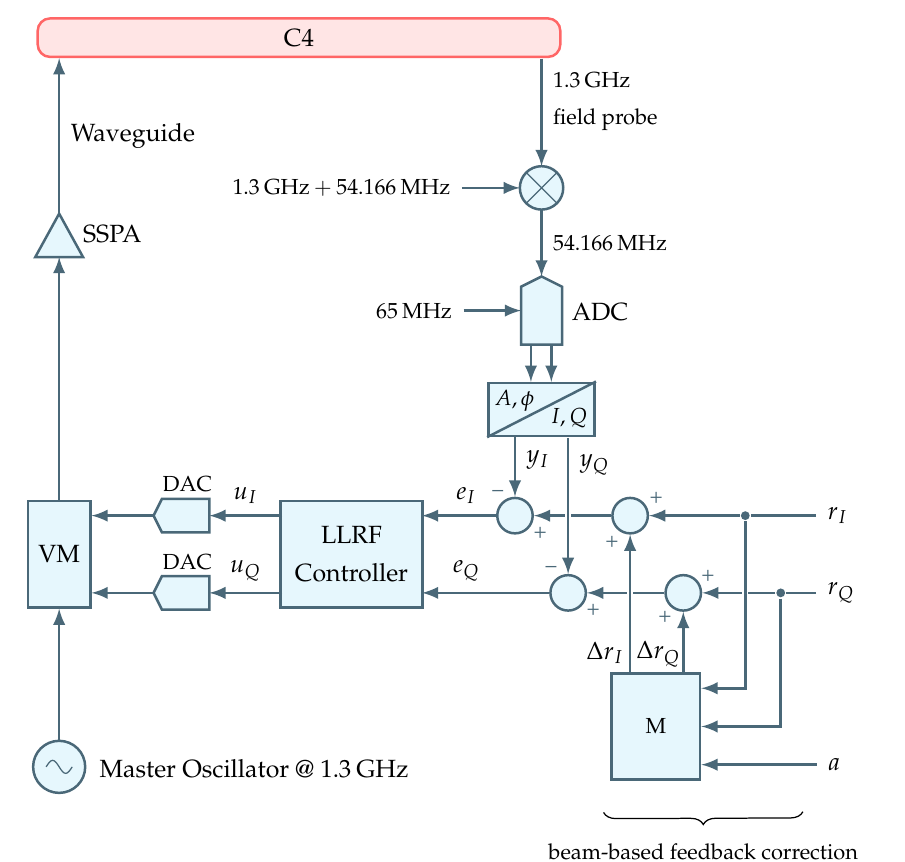
Figure 4. Schematic overview of RF system at ELBE including BBF